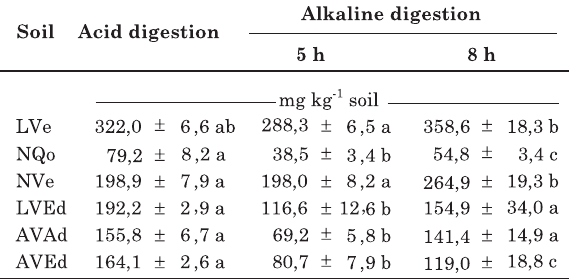
Table 6. Total S by acid and alkaline digestion, using a NaHCO + Ag O oxidation mixture (2.0/0.2 g) 3 2 at a temperature of 650 °C (n = 5)